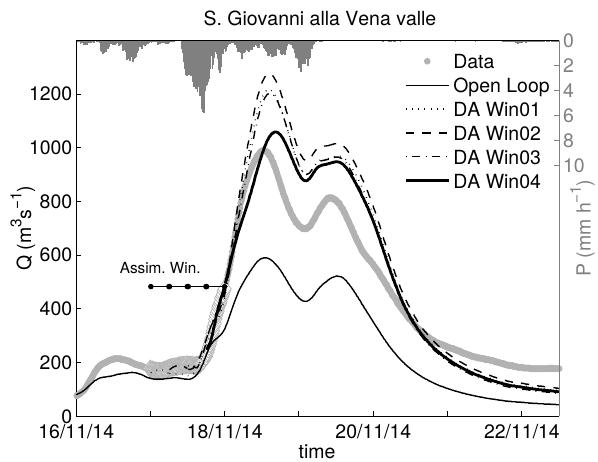
Figure 5. Hydrographs at S. Giovanni alla Vena measurement sta- tion for the flood event of 18 November 2014. Lines, symbols and acronyms maintain the same meaning of Fig. 3.